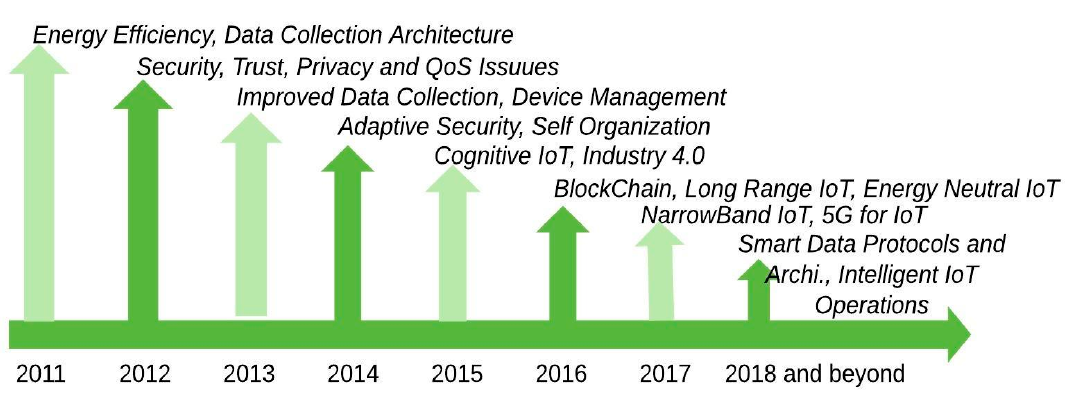
Table 1. Summary of related